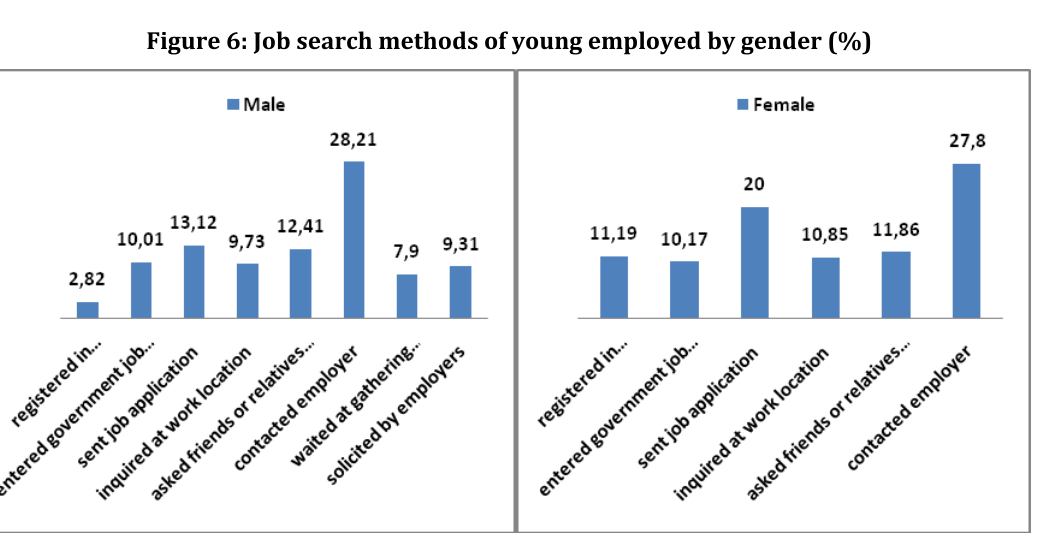
Question: How obtained main job Source : TLMPS 2014 and authors’